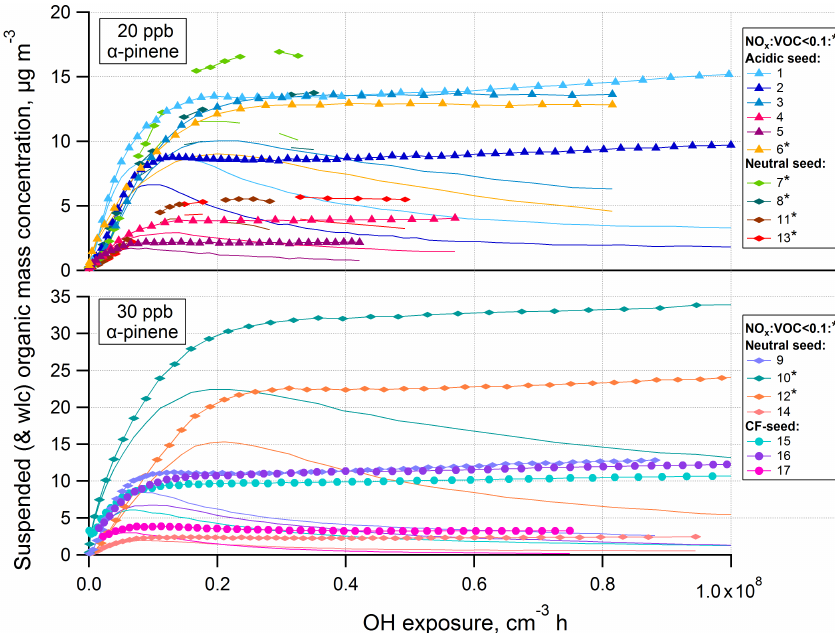
Figure 1. The 20min averaged wall-loss-corrected (symbols and lines) and suspended (lines) organic mass concentrations as a function of OH exposure. Data are separated according to similar initial α -pinene concentrations (20ppbv – top panel; 30ppbv – bottom panel). Experiment numbers are given in the legend and classified by seed composition; asterisks indicate low NO x experiments.